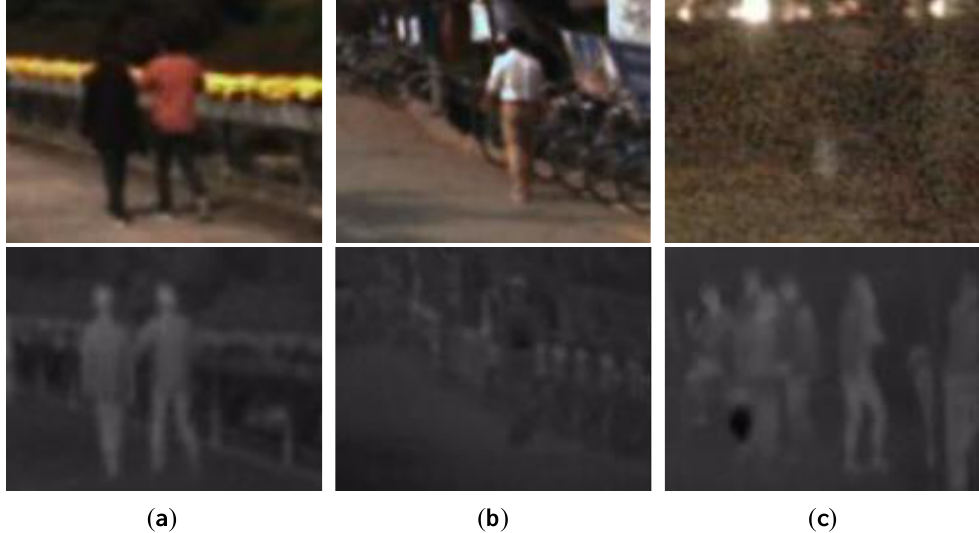
Figure 1. Typical samples of multispectral pedestrian images. The first and second row are visible and thermal images, respectively. ( a ) Both visible and thermal images are captured in good conditions. ( b ) Thermal image is captured at ambient temperatures similar to the body temperature and the thermal crossover may occur, leading to blurred and low-contrast results, while the quality of visible image is still good. ( c ) Visible image is captured under an extreme lighting condition, while their paired thermal image is robust against the illumination